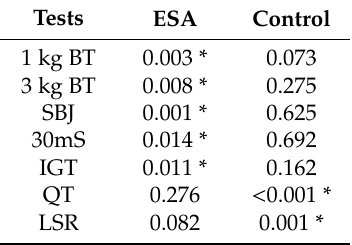
Table 2. Statistical di ff erences between t1 and t2 of both the ESA and control